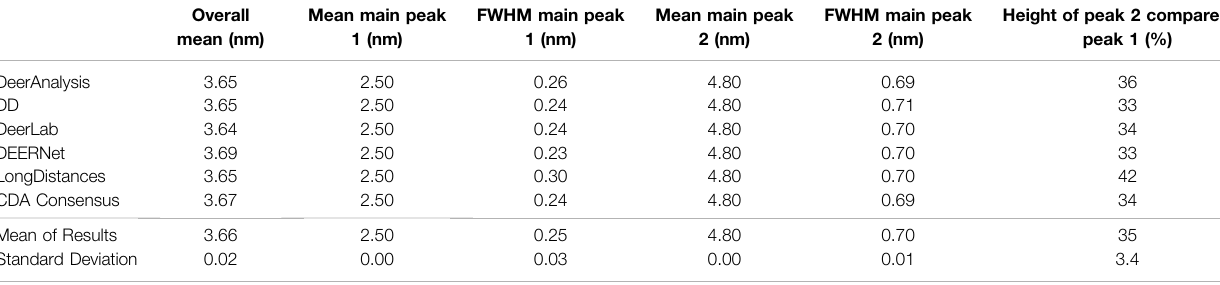
TABLE 4 | Results from each program for the simulated DEER-with-no-noise data set.